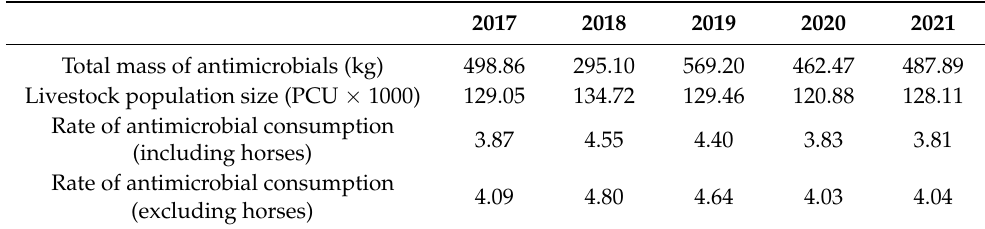
Table 5. Overall annual antimicrobial consumption by livestock.